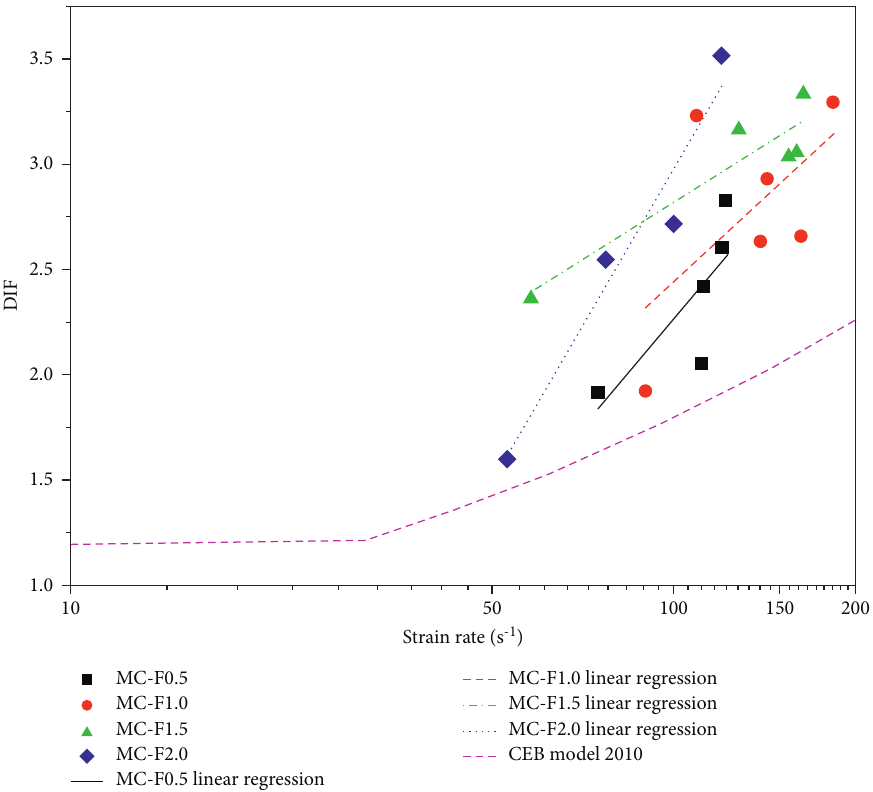
Figure 8: Dynamic increase factor for medium strength